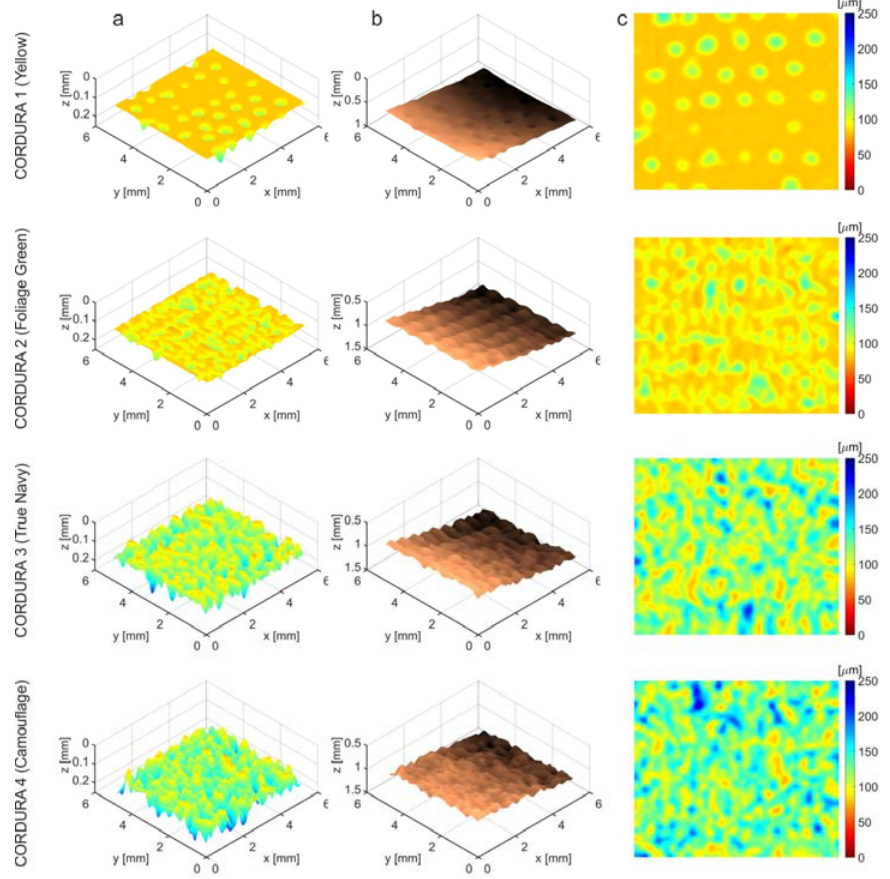
Figure 13. Exemplary thickness maps of the polyurethane layers in different Cordura samples (categories): ( a ) perspective view; ( b ) internal boundary depth; ( c ) XY ‐ plane).